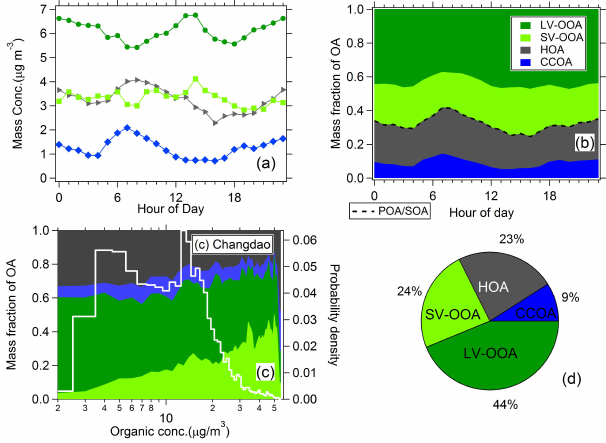
Fig. 6. Diurnal variations of concentrations and (a) fractions in OA; (b) for different OA components. (c) The fractions of different OA components in total OA as a function of concentrations of OA. (d) The average mass fraction of each OA